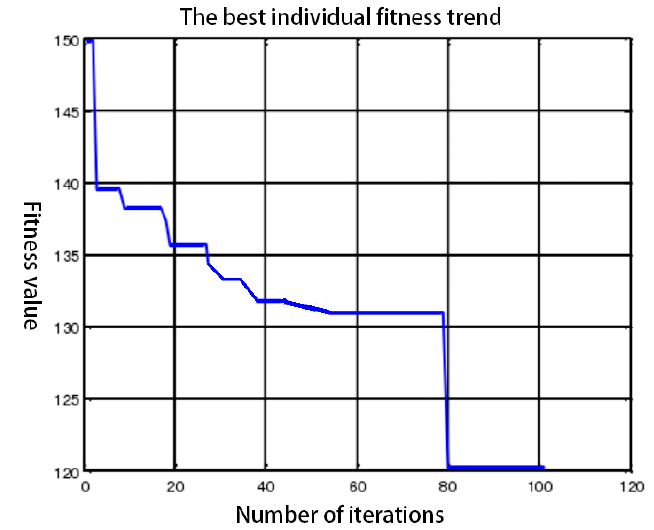
Figure 12. Fitness curve of traditional GA algorithm for the Problem 1.